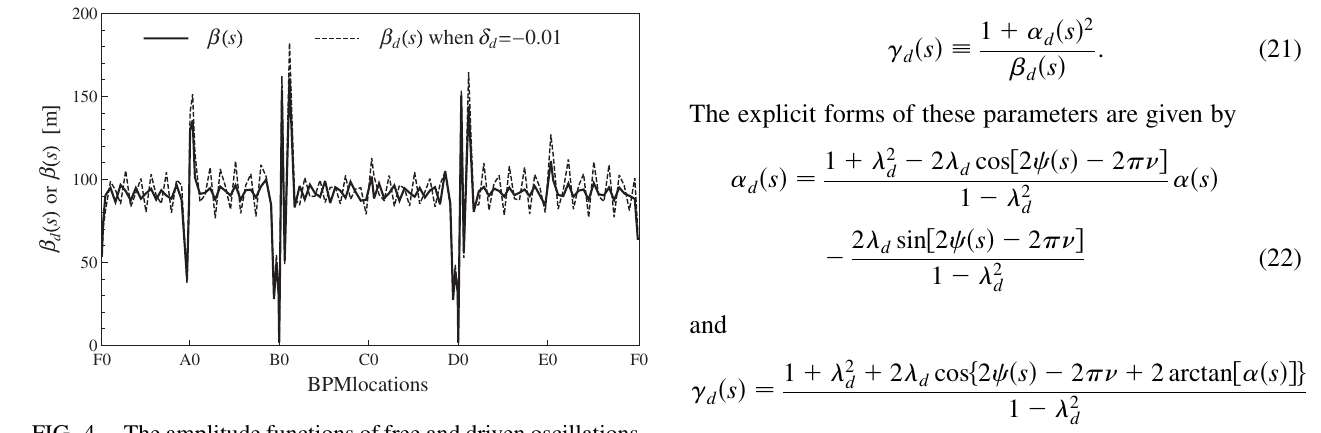
FIG. 4. The amplitude functions of free and driven oscillations, s Þ when (cid:3) 0 : 01 (dashed), in the (cid:1) ð s Þ (solid) and (cid:1) d ð d ¼ (cid:1) Tevatron. As expected, (cid:1) d ð s Þ shows beating with 10%–15% peak height relative to (cid:1) ð s Þ . From multiple data sets of driven oscillations, the amplitude function of free oscillations, (cid:1) ð s Þ , can be extrapolated.